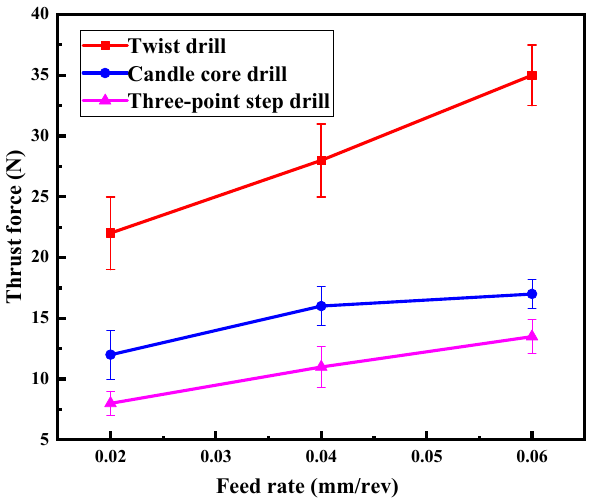
Figure 12. Curve of cutting force with feed rate.